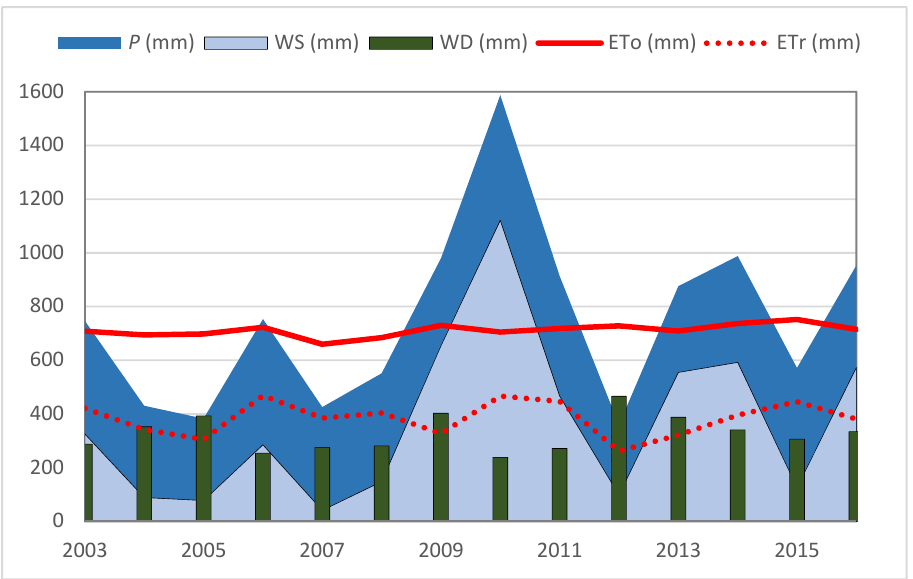
Figure 2. Annual values of the soil water balance variables in Bragança over the study period (2003–2016): precipitation ( P ) and reference evapotranspiration (ETo), actual evapotranspiration (ETr), soil water deficit (WD) and superavit (WS).